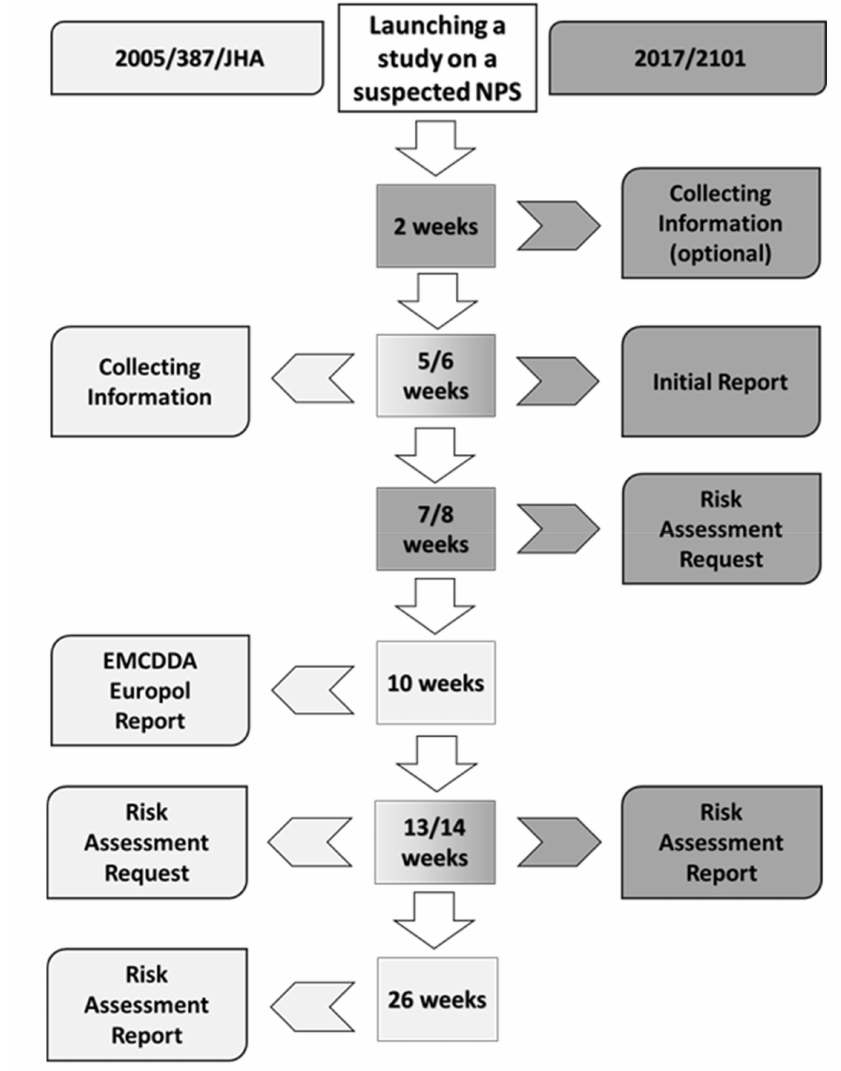
Figure 3. Shorter deadlines of the New Release No. 8 / 2018 procedure compared to the European Council Decision 2005 / 387 / JHA procedure. The illustration is a simplified version of the figure available in the EMCDDA page at https: // www.emcdda.europa.eu / publications / topic-overviews /